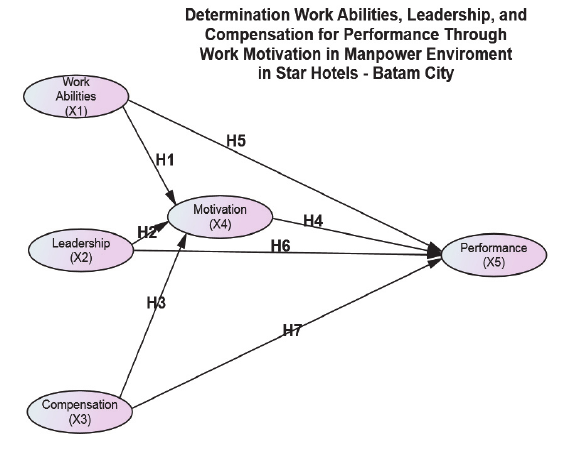
Fig. 1. Research Framework with SEM Analysis